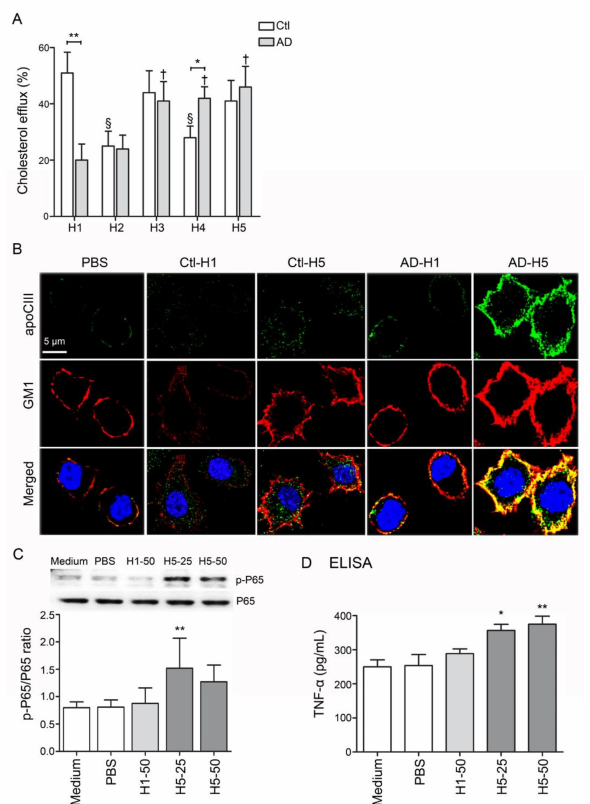
Figure 3. Analysis of function and proinflammatory properties of HDL subfractions. ( A ) RCT function was reduced in comparison with H1 HDL from healthy subjects. ( B ) AD-H5 induced a higher expression level of GM1 on the membrane and co-localized with APOCIII. ( C , D ) AD-H5 HDL induced p-P65 and TNF- α overexpression in RAW 264.7 cells. * p < 0.05, ** p < 0.01. Abbreviations. AD: Alzheimer’s disease; Ctl: controls; PBS: phosphate-bu ff ered saline; apoCIII: apolipoprotein CIII; GM1: ganglioside GM1; TNF- α : tumor necrosis factor- α